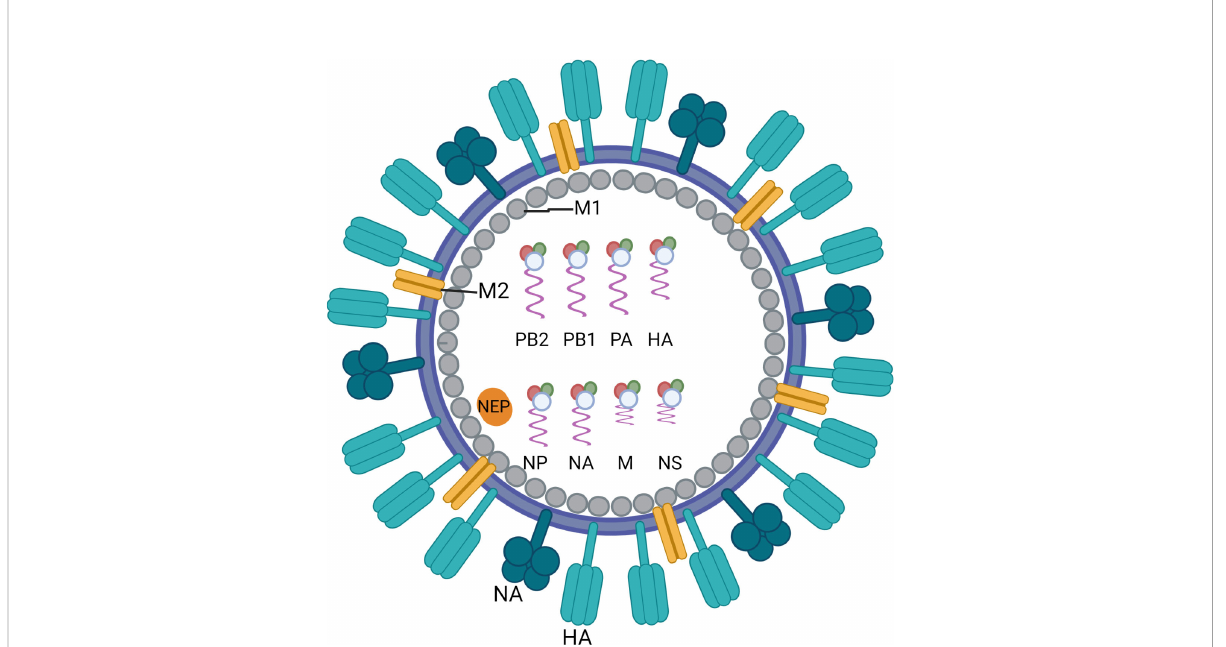
FIGURE 1 Schematic overview of the structure of an in fl uenza virus particle. Both in fl uenza A and in fl uenza B viruses are enveloped negative-sense RNA viruses with genomes comprising eight single-stranded RNA segments located inside the virion. The three largest RNA segments encode the three subunits of the viral RNA-dependent RNA polymerases (PB1, PB2 and PA). The smaller RNA segments encode for haemagglutinin (HA), which mediates viral entry in epithelial cells by binding to sialic acid-containing receptors, and nucleoprotein (NP) which binds to the viral genome. The smaller RNA segments can encode for more than one protein. They mainly encode for neuraminidase (NA) which enables virus release from the host cell, matrix protein M1 (M1) and matrix protein M2 (M2), the non-structural protein (NS1) and the nuclear export protein (NEP). Figure created with